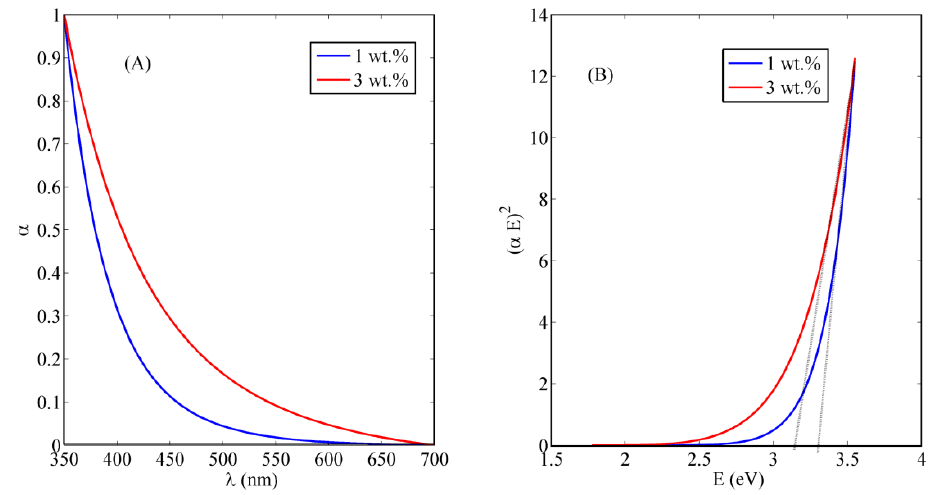
Figure 3. ( A ) Absorbance dispersion and ( B ) direct allowed bandgap calculations of polyvinyl alcohol (PVA) nanofibers with in-situ embedded different weight concentrations of ceria nanoparticles (NPs).